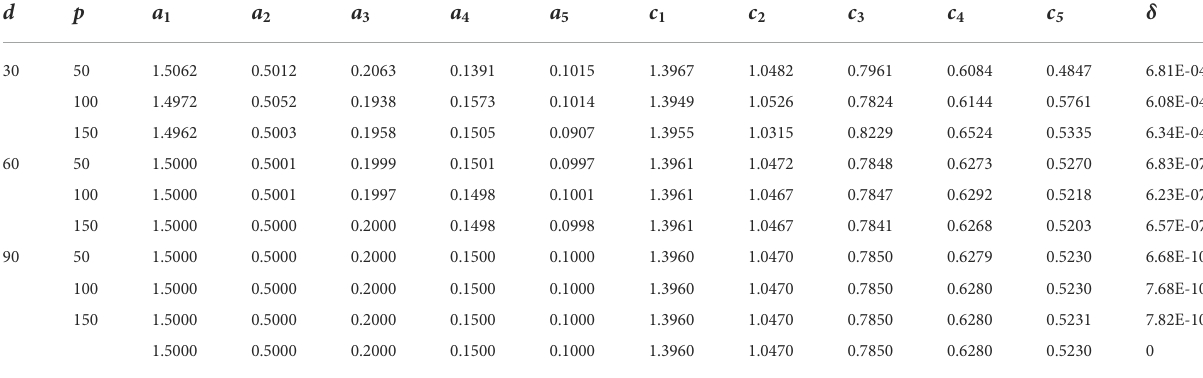
TABLE 3 Results of parameter estimates of Example 1 for G =